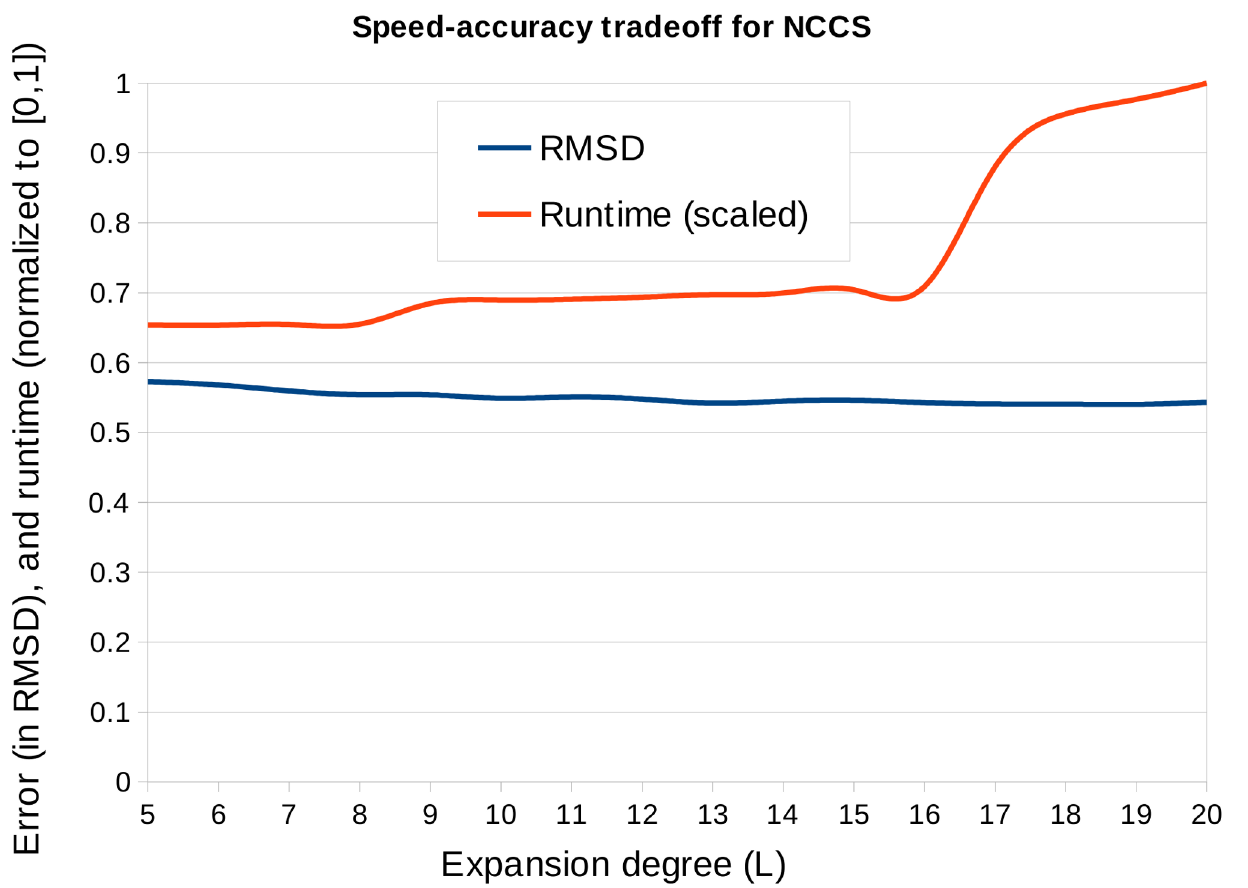
Fig 10. Speed-accuracy trade-offs for NCCS. NCCS is computed on a non-uniform grid based on the atom positions. If the grid is sparse, then it is expected that a lower degree expansion of the spherical basis functions would sufficiently represent it. We applied NCCS with the expansion degree (L) varied between 5 to 20, on the synthesized EM dataset (blurring to 12A resolution) and using 30k samples in SO(3) space. The plot shows that the error decreases and runtime increases with L. However, the change is runtime is more pronounced than the change in error, for example, the runtime is 35% faster for L = 5 while the error is only 5% more than that of L =